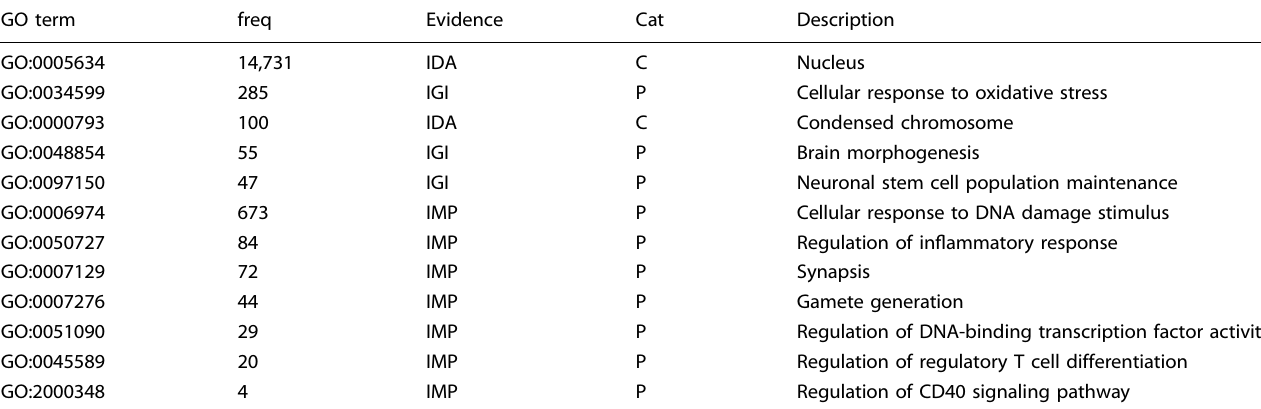
Table 6. GO terms present in Mouse Fancd2 but not Human Trim25, along with the global frequency of the GO term, the evidence code, the GO Category (Biological Process, Cellular Component), and description. GO